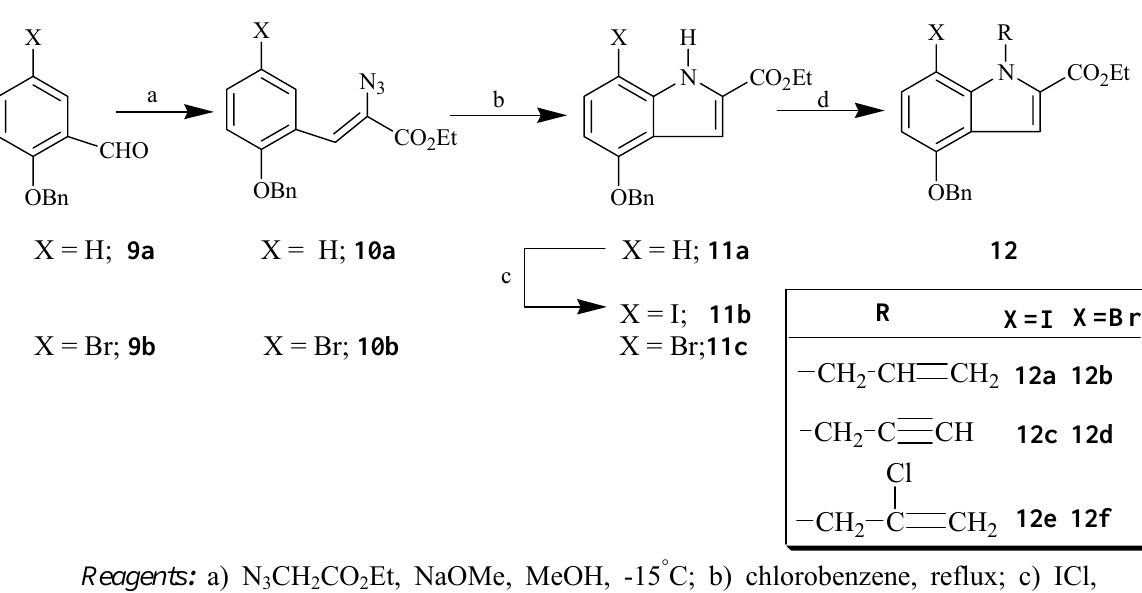
Scheme 1: Synthesis of Ethyl N-substituted